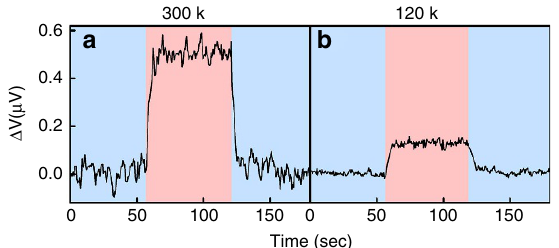
Figure 7 | Hall potential measured for a mixed monolayer. Measurements were conducted at ( a ) 300K and at ( b ) 120K, at a current of 10 m A, for devices as in Figs 4 and 5, but with a mixed monolayer consisting of 40% NH 2 -{Ala-Aib} 8 -COCHNH 2 CH 2 PO 4 H 2 , 60% 11- mercaptoundecylphosphoric acid [HSCH 2 (CH 2 ) 9 CH 2 PO 4 H 2 ] molecules. The signal observed corresponds to effective magnetic fields of 11 and 3G for the high and low temperature,